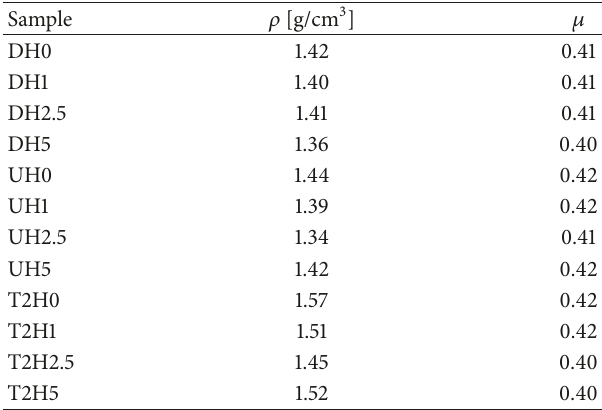
Table 3: Apparent density and Poisson ratio for POM and POM/HAp